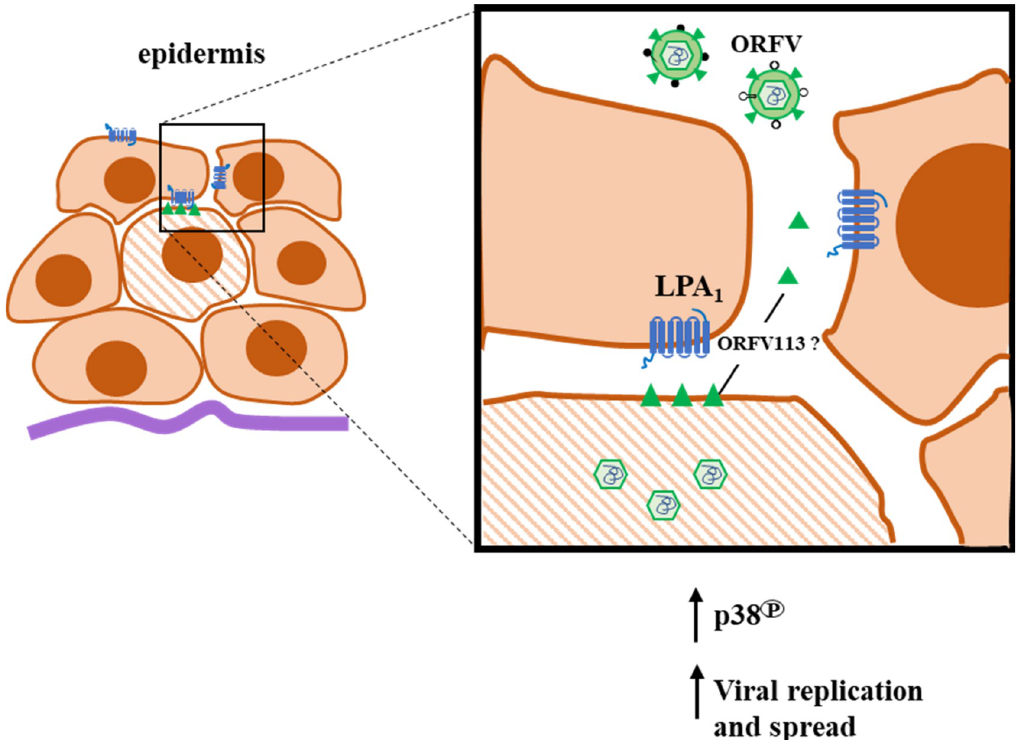
Fig 13. Proposed function of ORFV113 during infection of the epidermis by ORFV. LPA-p38 signaling targeted by ORFV113 might exert an effect on p38 signaling in neighboring cells in a virus plaque or focal lesion in ORFV infected epidermis. ORFV113 interacts with GPCR, LPA 1 and enhances p38 phosphorylation in ORFV infected cells. ORFV113 expressed in the membrane of infected cells might be interacting with LPA 1 on adjacent cells in a juxtacrine manner, leading to p38 phosphorylation in neighboring cells. Alternatively, soluble ORFV113 may perform the same function in a paracrine manner as ORFV113 is present in the supernatant of infected cells. The mechanism by which ORFV113 is present in the supernatant is yet to be